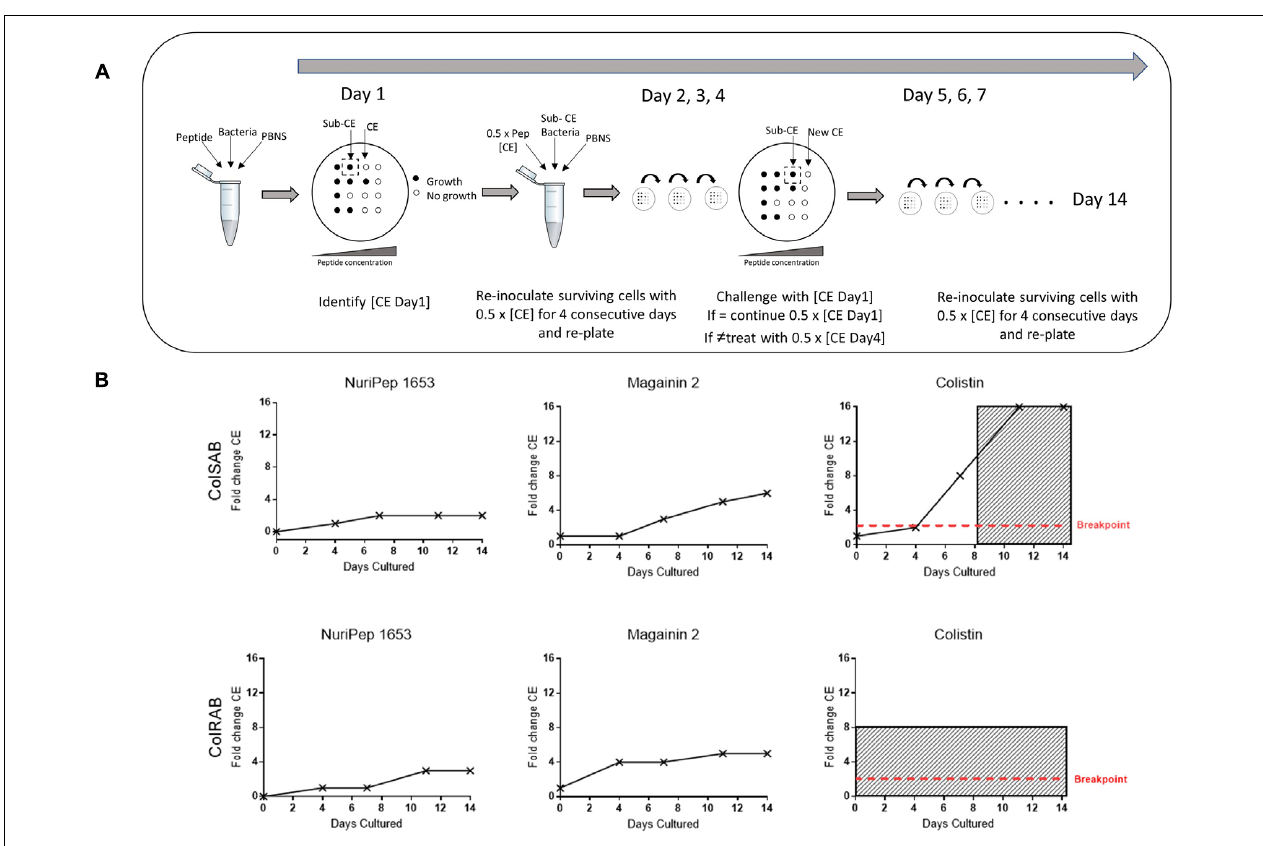
FIGURE 8 | Assessment of the development of resistance to NuriPep 1653, magainin 2 and colistin in colRAB and colSAB over 14 sequential passages. A schematic representation of the resistance assay is shown in (A) . On day 0, bacterial cells were diluted in PBNS to 1 × 10 4 cells/mL and were treated with either colistin, magainin 2 or NuriPep 1653 at a range of concentrations for 90 min. The CE concentration was determined on day 1 after 18 h. This was repeated throughout the experiment. On days 4, 7, 11, and 14, the bacteria were challenged with the previously determined CE concentration. Where the killing concentration was higher than that on day 0, the treatment for the following 3 days was increased to one half of the new CE concentration. The CE concentrations represented as a fold change over 14 days during repeated exposure of colSAB with sub inhibitory doses of NuriPep 1653, magainin 2 and colistin from left to right are shown in the top row (B) and again against colRAB in the bottom row. The development of resistance was defined as > 10-fold the CE and is shown as shaded areas in the graphs (Deslouches et al., 2015). Colistin resistance in ColRAB was previously determined (Machado et al., 2018) and confirmed by the EUCAST breakpoints and is represented as resistant from day